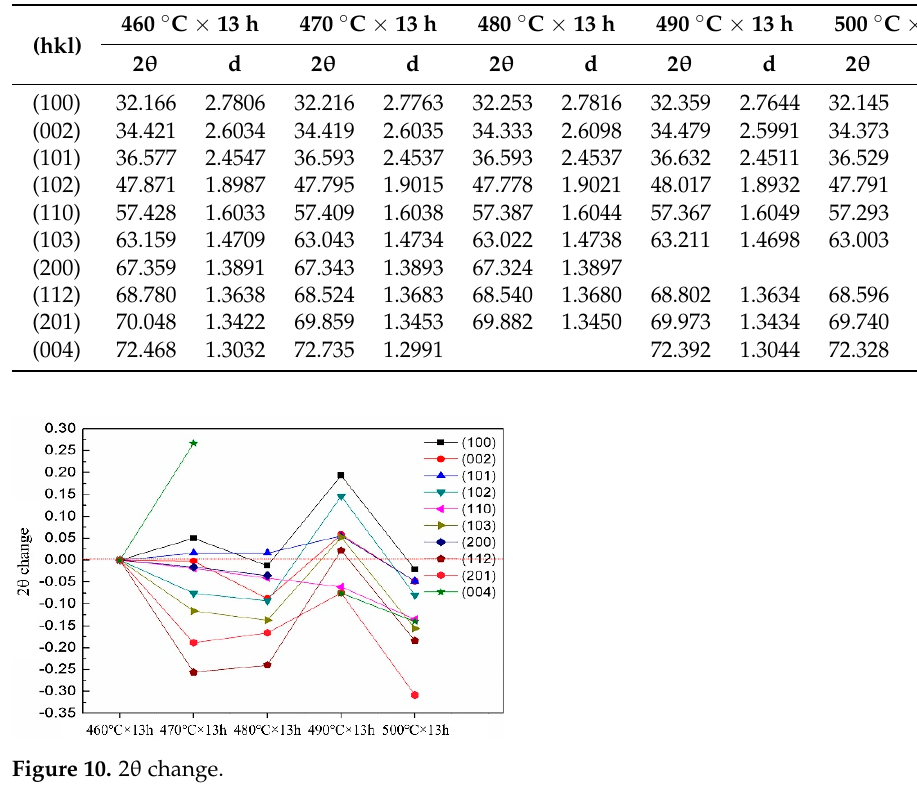
Table 3. The 2 θ and d of Mg–9Gd–2Y–2Zn–0.5Zr alloy by different solution treatment.